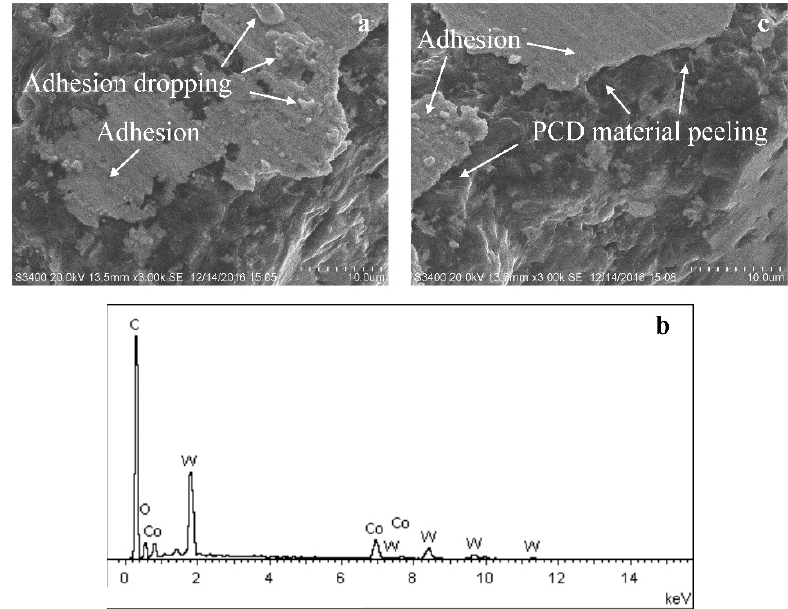
Figure 11. The adhesive wear mechanism on bottom surface. ( a ) Adhesions on bottom surface; ( b ) element compositions of adhesions; ( c ) dropping of tool material.